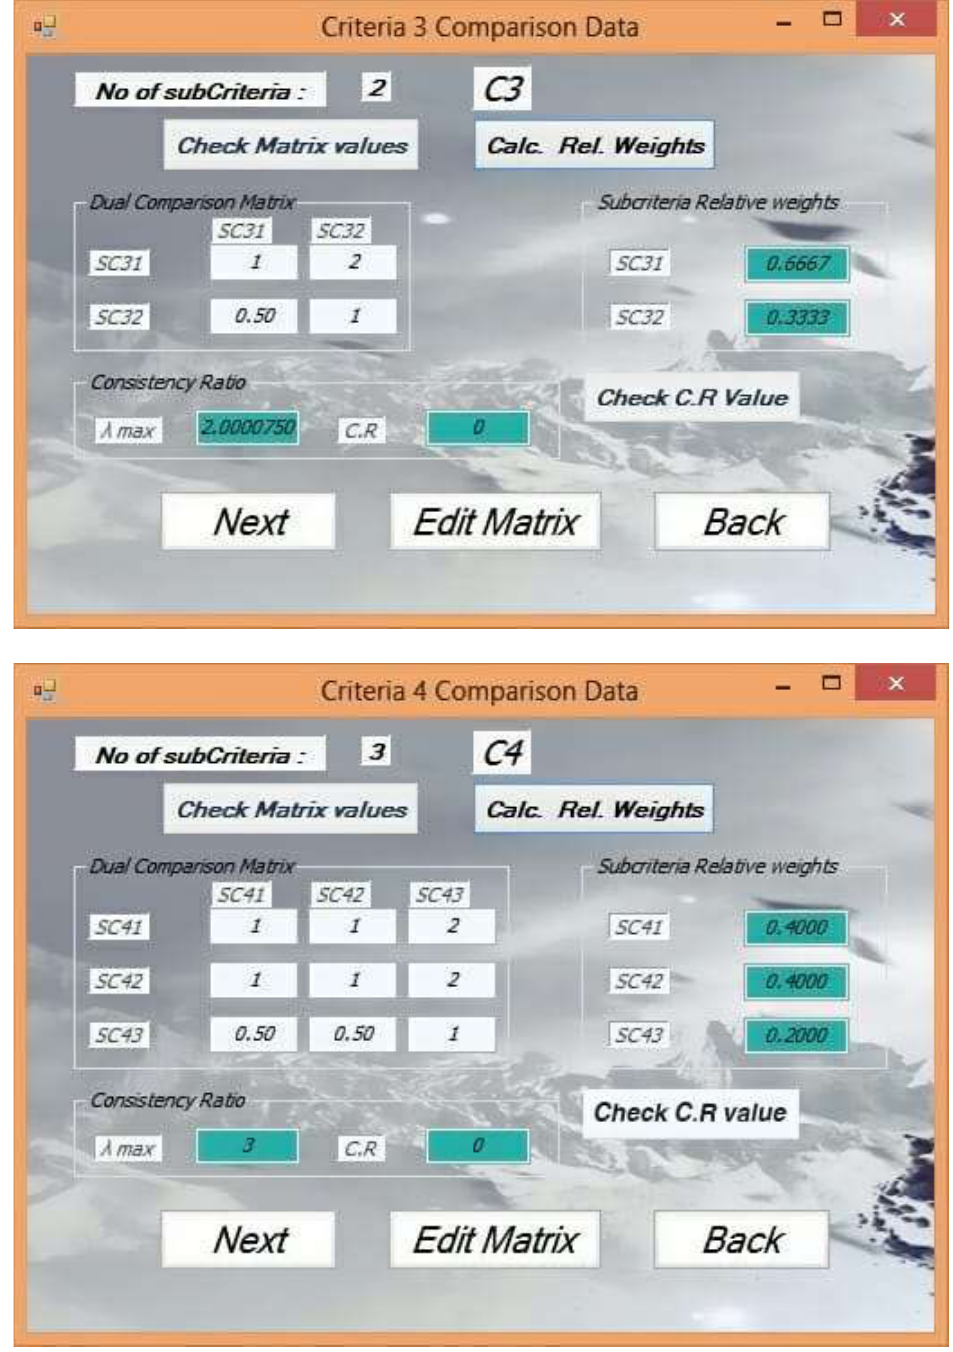
Figure 6. Relative weights of criteria and sub-criteria, and C.R values. The decision-making group adopted TFNs “7” levels to get the benefit of applying lin- guistic variables in the decision-making process. Then, all alternatives were compared with the criteria affecting the decision. The experts’ preferences, which are defined throughout this stage, are shown in Figure 8. The decision-making members provided their individ- ual judgments to a designed software where an aggregation technique was employed to synthesize their preferences. They also worked in close cooperation to make consensual judgements for each pairwise comparison matrix for the AHP